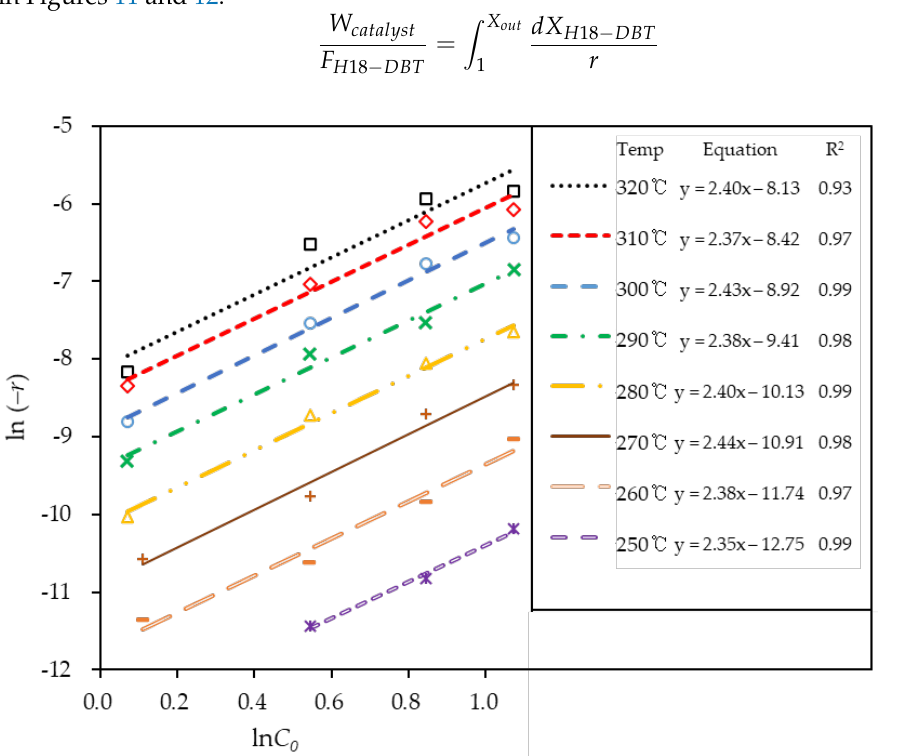
Figure 9. Linearized equation plot of the reaction rate ( − r ) and molar concentration ( C 0 ) used for evaluating the reaction order (n) and reaction constant ( K ) for the kinetic model of dehydrogenation of H18-DBT.